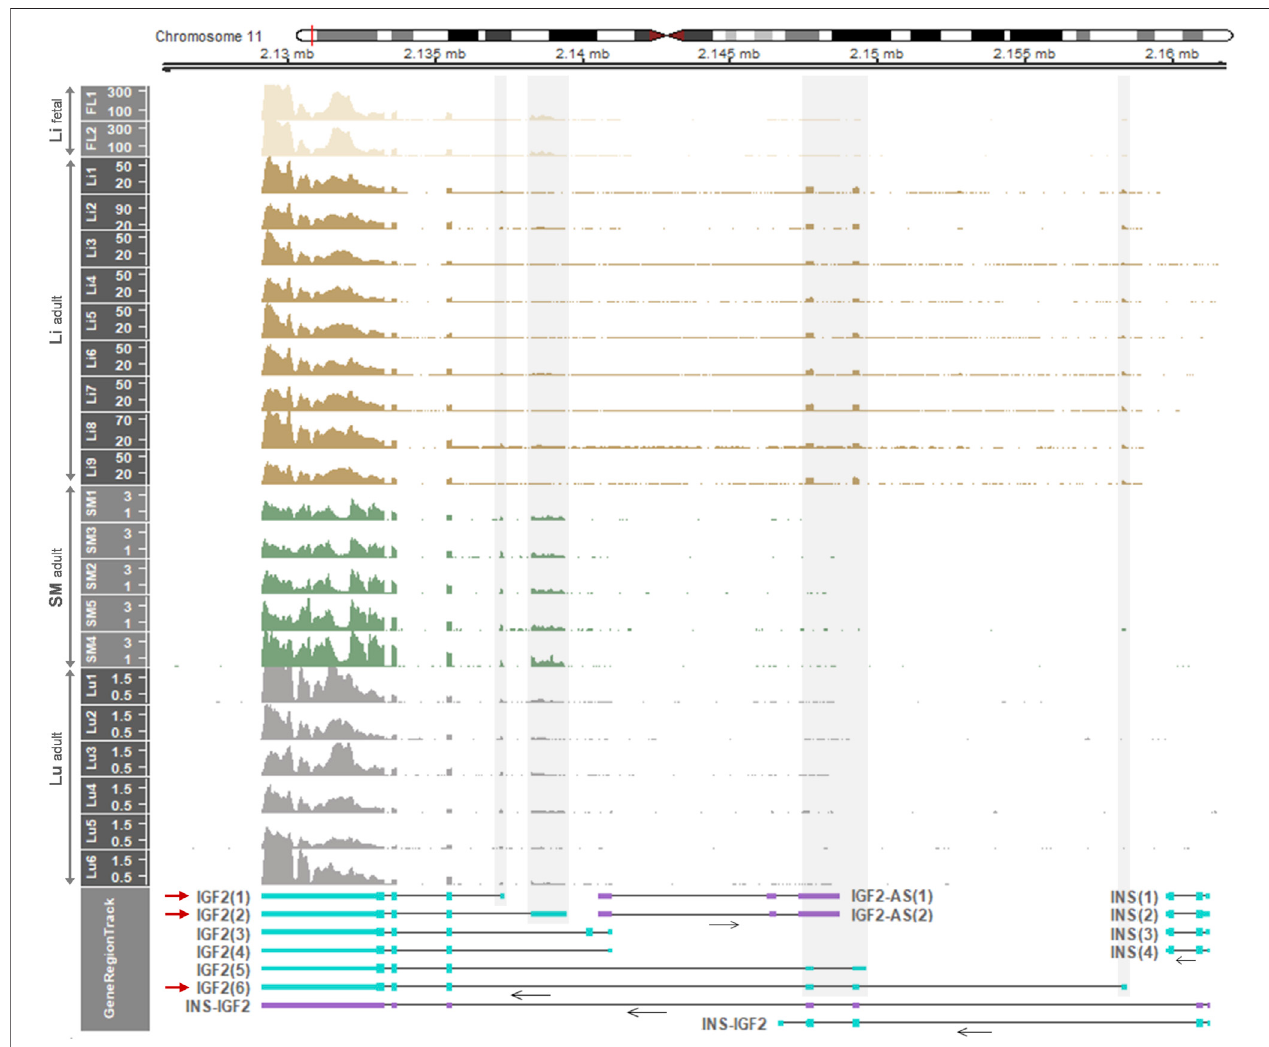
FIGURE6| Temporaland spatial differences ofexpressed IGF2 transcriptsinthehuman.Displayed aremRNAexpression ofthe IGF2 geneinthehumanfetal liver (Li),adultliver(Li),adultsmoothmuscle(SM),andadultlung(Lu).RNA-seqdatawereretrievedfromdatasets:GSE63634forfetalliver,hum0158.v2fornormaladultliver, SRP166862 for normal adult smooth muscle, and PRJNA395106 for normal adult lung. Read coverages are represented as TPM values on the y-axis. In GeneRegionTrack, transcripts of IGF2 , INS-IGF2 fusion, IGF2-AS , and INS genes located in the 0.0365-Mb (36.5-Kb) region (chr11:2,125,500-2,162,000) are displayed by either light blue boxes [tall, translated regions; short, untranslated regions (UTRs)] for protein-coding or purple boxes for non-coding. Horizontal arrows undertranscripts indicate thedirectionoftranscription.Greyshades overlaynon-overlapping exonswithhigh readcoverages correspondingtopredominant transcripts ( IGF2(1) , IGF2(2) and IGF2(6) ) with red arrows. Human gene transcripts include IGF2(1) , NM_001291861.3; IGF2(2) , NM_000612.6; IGF2(3) , NM_001127598.3; IGF2(4) , NM_001291862.3; IGF2(5) , NM_001007139.5; IGF2-AS(1) , NR_028043.2; IGF2-AS(2) , NR_133657.1; INS(1) , NM_001185097.2; INS(2) , NM_001185098.2; INS(3) , NM_001291897.2; INS(4) ,